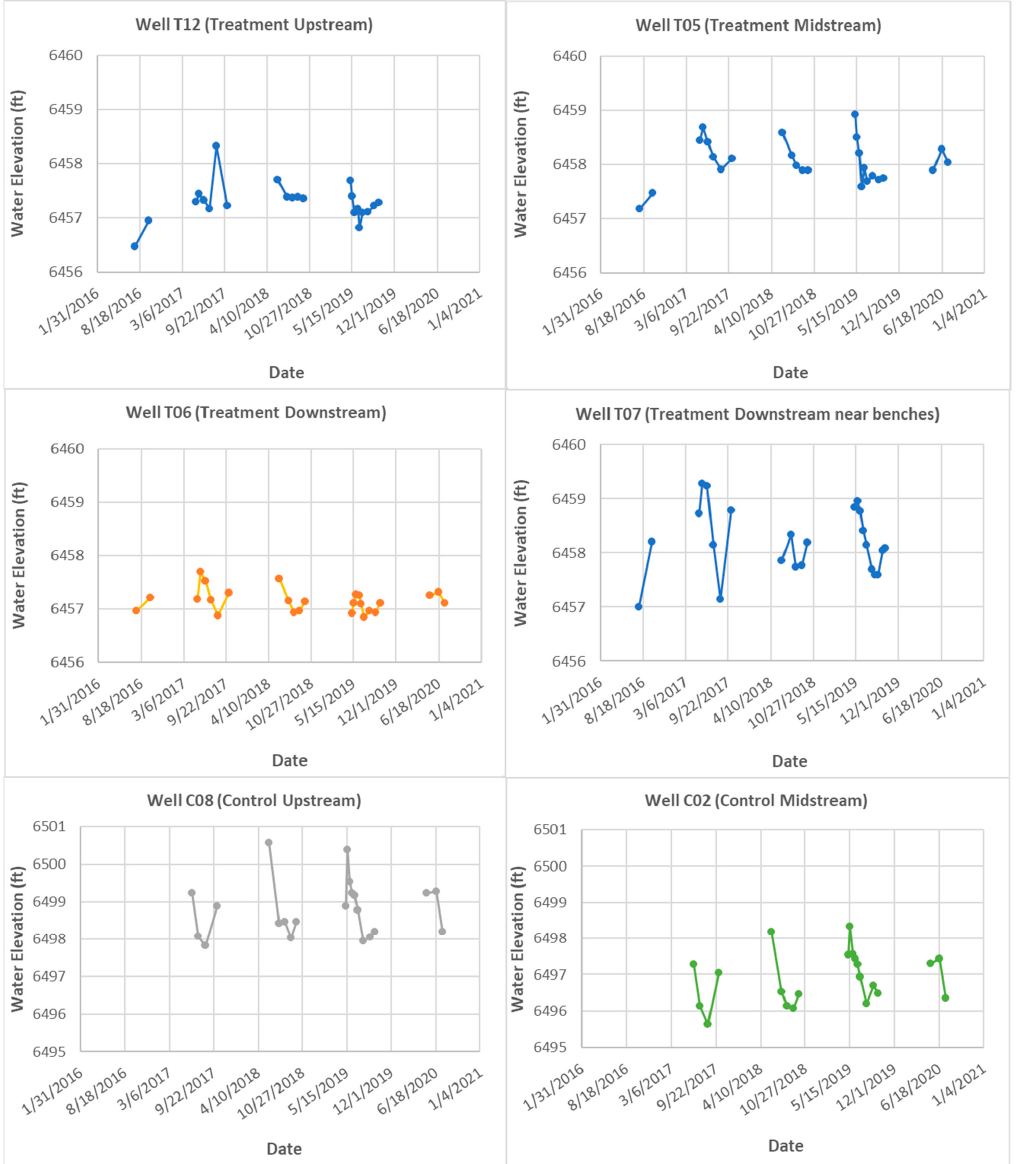
Figure 6. Groundwater elevations for wells in the treatment and control reaches on Blacktail Creek (data up to year 2019 are from Norman [24]; 2020 data are collected as part of this study). Flow measurements collected in the control reach 1 show that the creek is slightly losing during May and June and switches to slightly gaining (July) or gaining (August). The treatment reach, however, has the opposite trend and changes from gaining (May through July) to losing in August (Table 3). These patterns were also observed during measurements collected prior to this study [24].